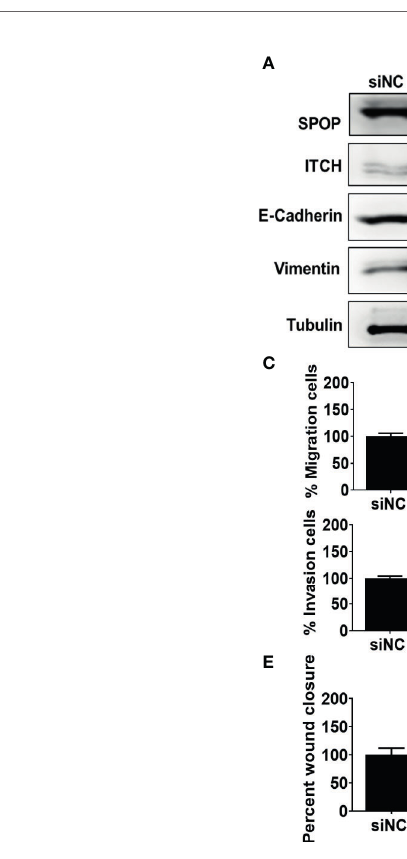
FIGURE 3 | Downregulation of SPOP promotes EMT. LN-CaP cells were transfected with control or SPOP siRNA, before they were subjected for the following assays: (A) Protein expression of E-Cadherin and Vimentin measured by Western blotting. (B) mRNA expression for TWIST, SNAIL and ZEB1measured by RT-PCR analyses. (C, D) Cell migration and invasion measured by the Modi fi ed Boyden chamber assay. (E, F) Cell migration measured by the wound-healing migration assay. **P < 0.01; ***P < 0.001; ****P <